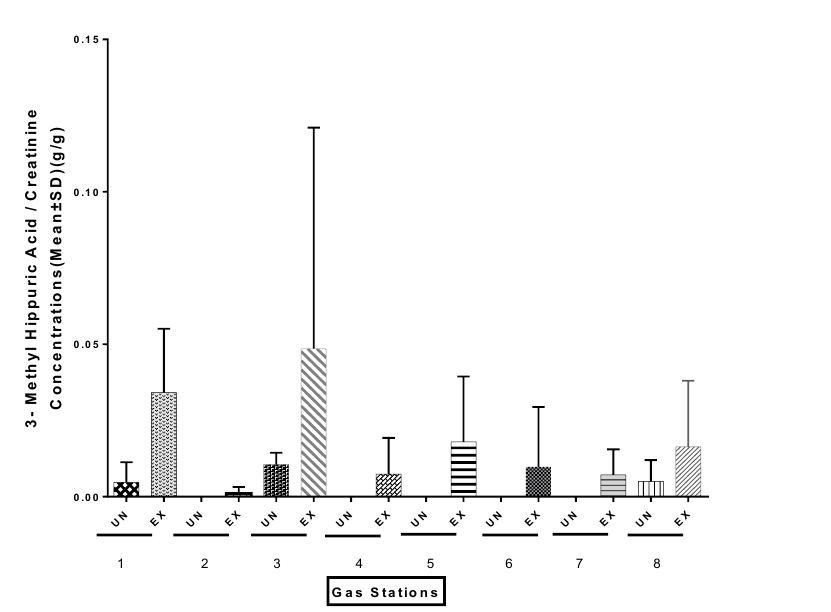
Figure 3. The Mean Concentrations of 3-MHA (g/g creatinine) at Each Gas Station in the Control and Exposed Groups Regardless of the Season Variable (UN: control group; EX: exposure group)